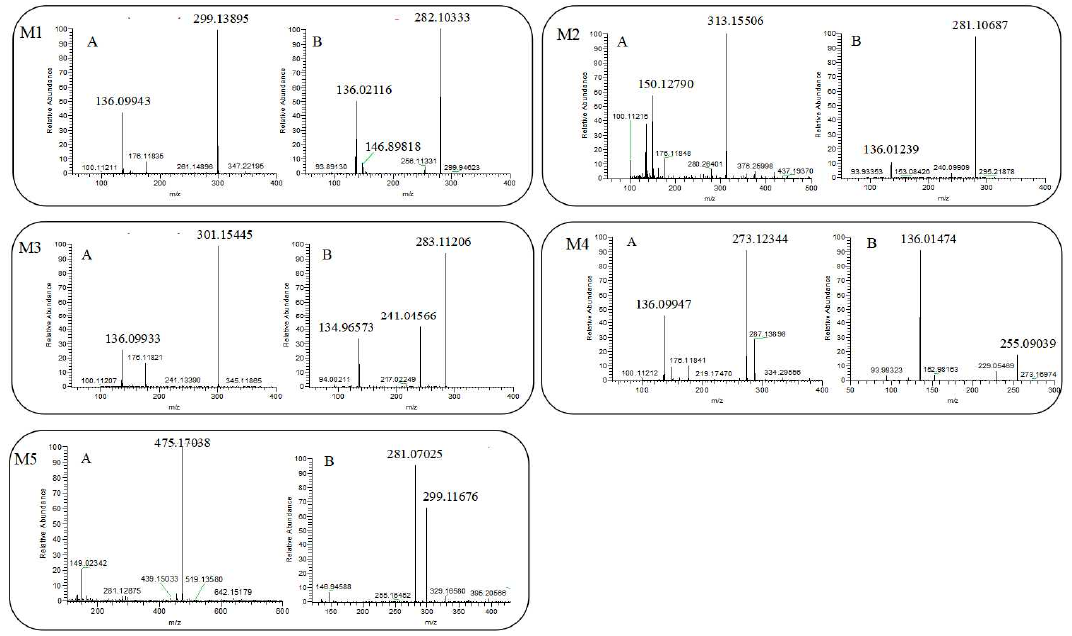
Figure 4. ( A ) Accurate mass spectrum of M1–M5; ( B ) the secondary cleavage of M1–M5.